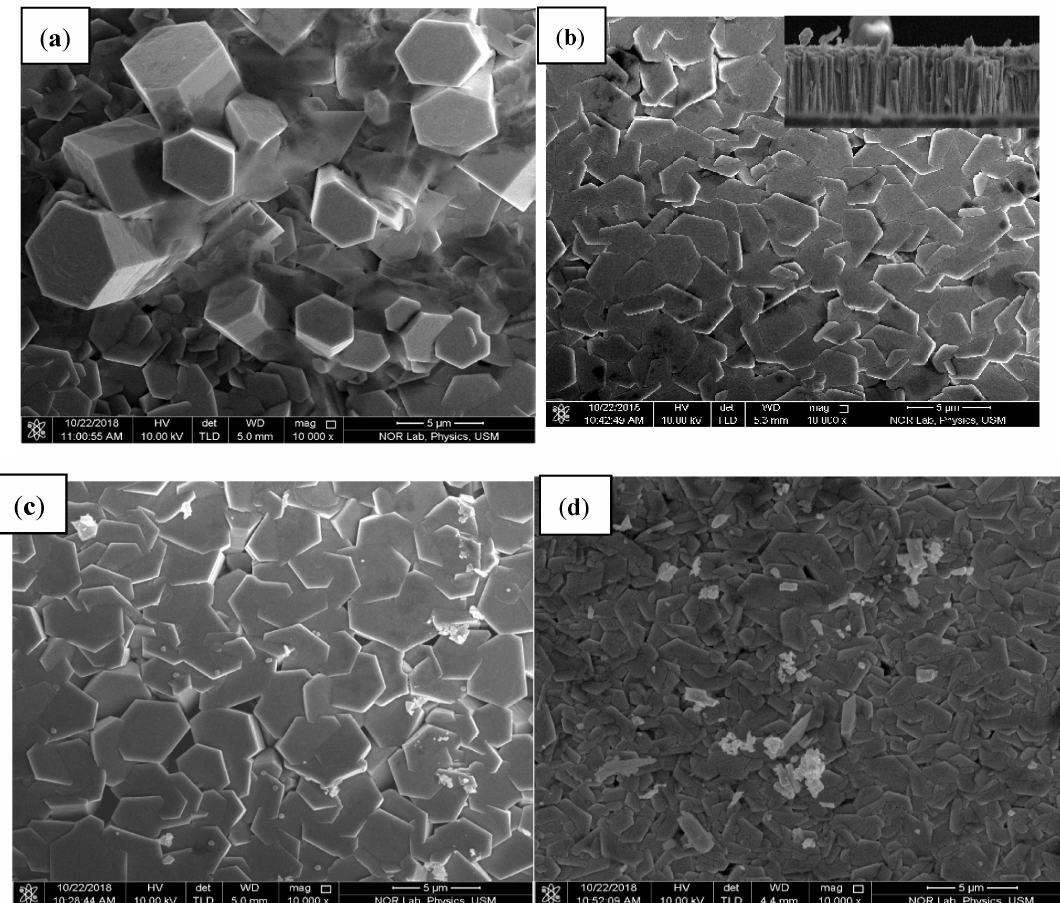
Figure 3. FE-SEM images of the ( a ) pure ZnO and silver dopant at ( b ) 0.5%; ( c ) 1%; and ( d ) 3%,